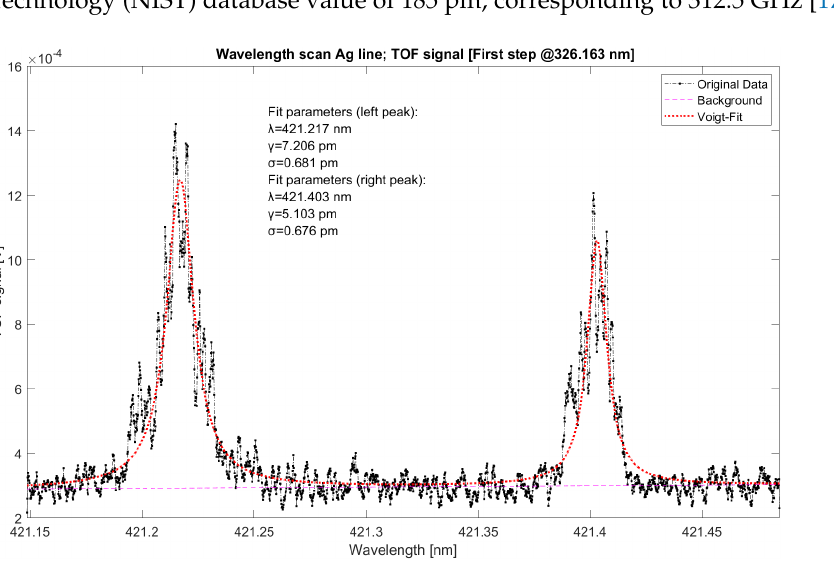
Figure 9. Fine structure of 4d 10 6d 2 D [J = 5/2 (left peak) and J = 3/2 (right peak)]. Scanning range = 330 pm (557.4